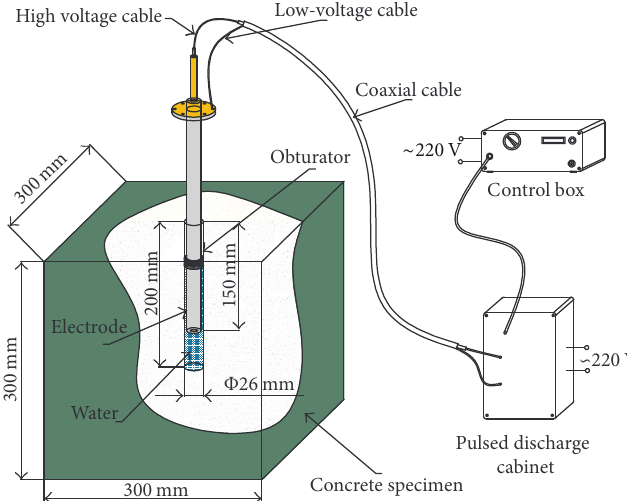
Figure 2: Diagram of experimental equipment.